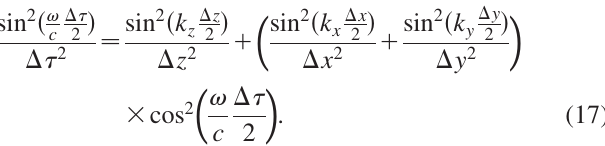
ffiffiffiffiffiffiffiffiffiffiffiffiffiffiffiffiffiffiffi